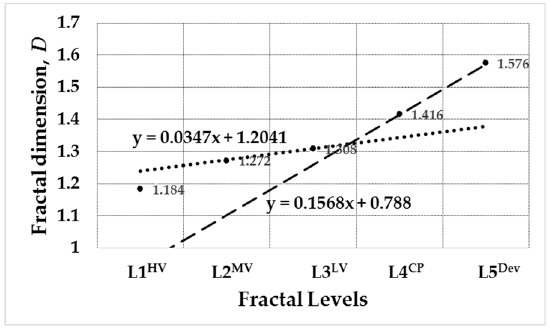
Figure 11. The fractal dimension D for di ff erent separate fractal